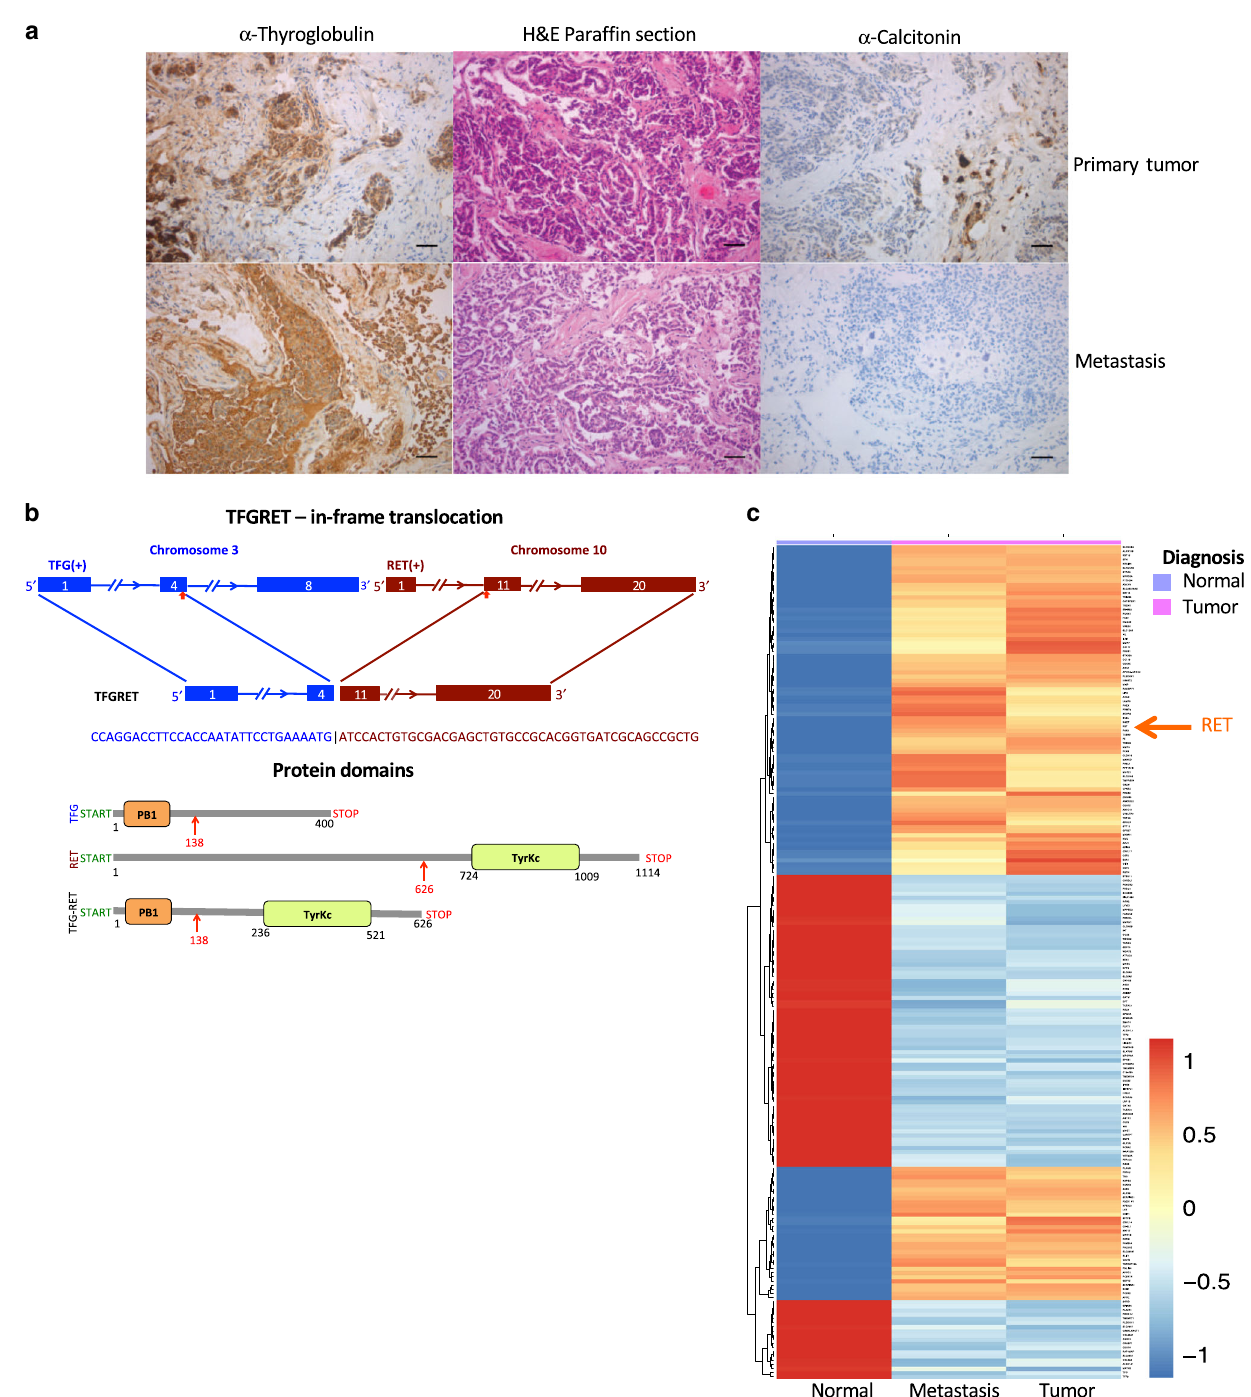
Fig. 1 A novel fusion product is identi fi ed in patient PTC sample. a Immunohistochemical analysis of patient samples. α -thyroglobulin expression was detected in both primary and LN metastasis tissues, implying that the tumor is a PTC. Haemotoxylin and eosin (H&E) staining shows follicular nature of the tumor. α -calcitonin was detected in some cells of the primary tumor tissue implying c-cell hyperplasia and there was no α -calcitonin expression in the metastatic tissue (magni fi cation ×20, Bar 50 μ m). Presented are representative data from a diagnostic staining procedure. b Diagrammatic representation of TFG-RET protein. TFG-RET contains 626 amino acids, and is a fusion between the N-terminal part of TFG protein and C terminus of RET protein. The TFG region (1 – 138) contains a PB1 domain, whereas the RET region (139 – 626) contains the tyrosine kinase domain. c Heat map of the RNA-seq analysis of normal vs tumor vs metastasis as mentioned in the Methods section. RET overexpression is indicated in the (Fig. 3a). PB1 domains are evolutionarily conserved protein- multimers of RET kinase, which is critical for the activation of the protein interaction motifs contributing to formation of oligo- kinase. Immunoprecipitation of exogenously expressed RET mers 17 . We hypothesized that the PB1 motif in the TFG-domain constructs and the gene fusion revealed that TFG-RET readily could possibly contribute to the formation of dimers and/or forms dimers and multimers, which was con fi rmed by